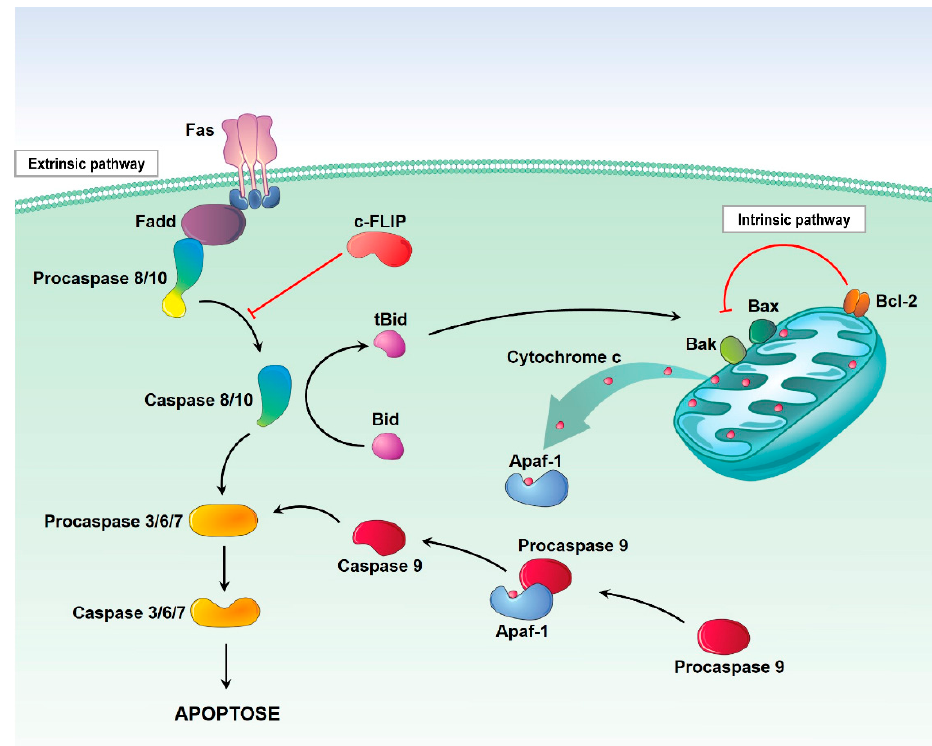
Figure 1. Pathways of apoptosis. Apoptosis can occur through two pathways: The extrinsic or the intrinsic pathway. The extrinsic pathway begins with the binding of extracellular ligands to death- promoting receptors, through the Fas-associated death domain adapter protein (FADD), then recruits procaspase-8, which in turn activates caspase-8. The intrinsic (or mitochondrial) pathway is regulated by a series of specific death-promoting molecules released from the mitochondria. Members of the pro- and antiapoptotic BCL-2 family compete on the surface of the mitochondria to control the release of cytochrome c. The released cytochrome c is associated with Apoptotic protease activating factor-1 (Apaf-1) and procaspase-9, which activate caspase-9. The two pathways share a common end point at the level of caspase-3 activation. The interaction between these pathways occurs through the Bid cleavage triggered by caspase-8. Bid’s interaction with Bax or Bak in the outer mitochondrial membrane results in the release of cytochrome c. The antiapoptotic BCL-2 family can prevent such a release by direct interaction with Bax and/or Bak.